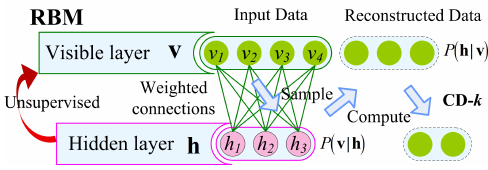
Figure 3. The basic model of